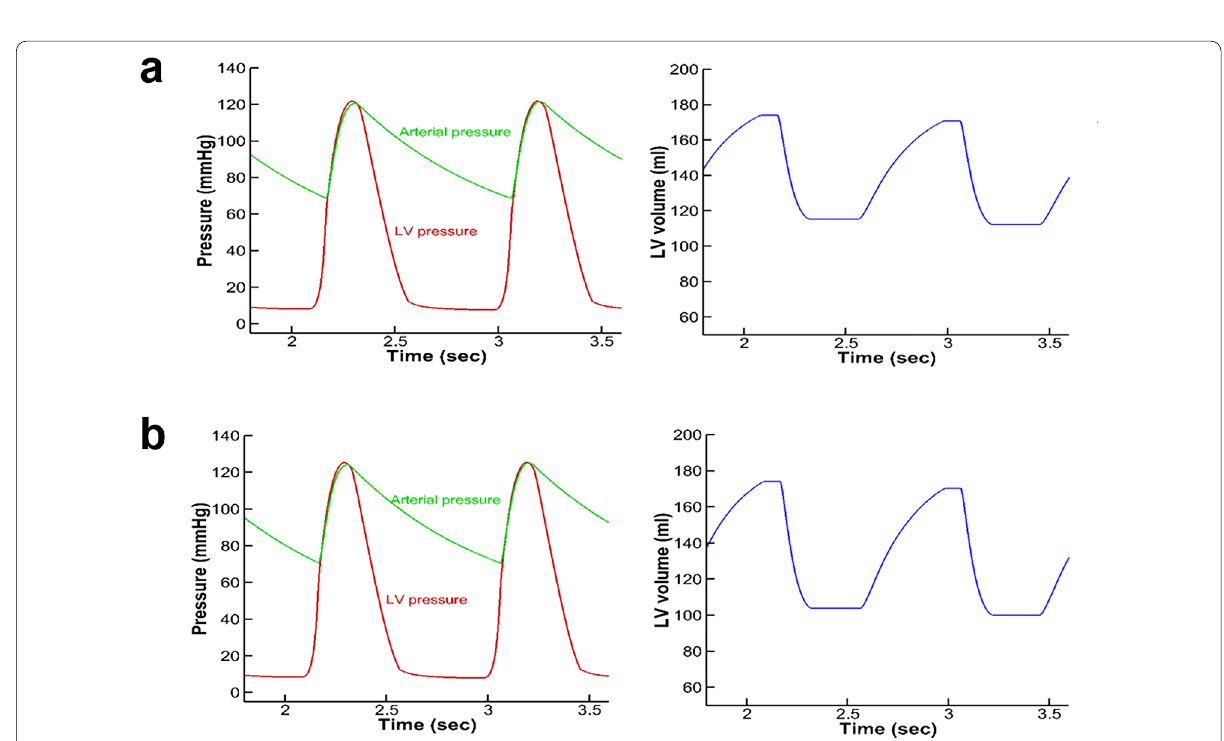
Fig. 6 Changes in pressure and LV volume with time under the LBBB (a) and CRT (b) conditions. CRT increased systolic LV pressure from 120 to 124 mmHg and decreased LV end‑systolic volume from 116 to 104 mL, that resulted in increased LVEF from 33 to 40%. CRT resynchronization therapy, LBBB left bundle branch block, LV left ventricle, LVEF left ventricular ejection = = =